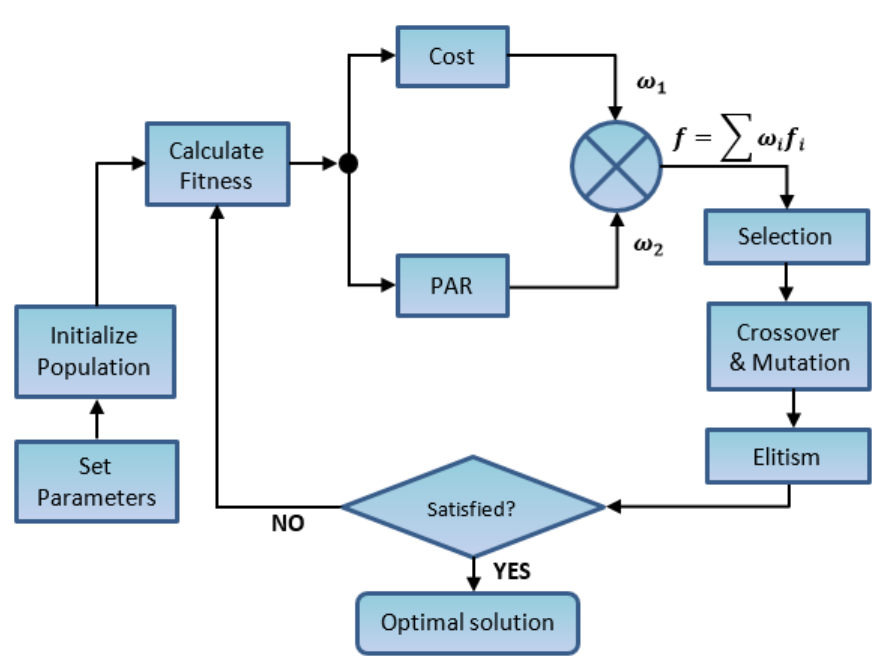
Figure 2. Flowchart of the proposed BCGA optimization.